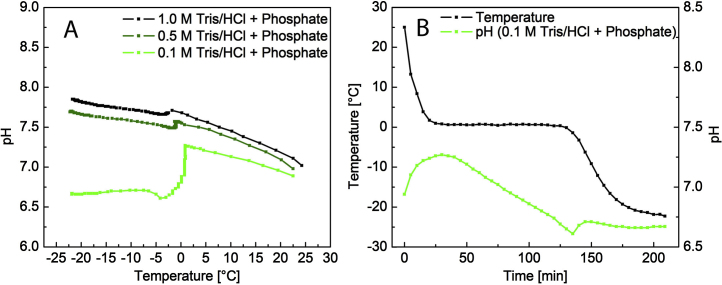
pH shifts during freezing of Tris/HCl buffer plus 15.7 mM phosphate measured at three different TRIS concentrations (initial pH value was pH 7.0).